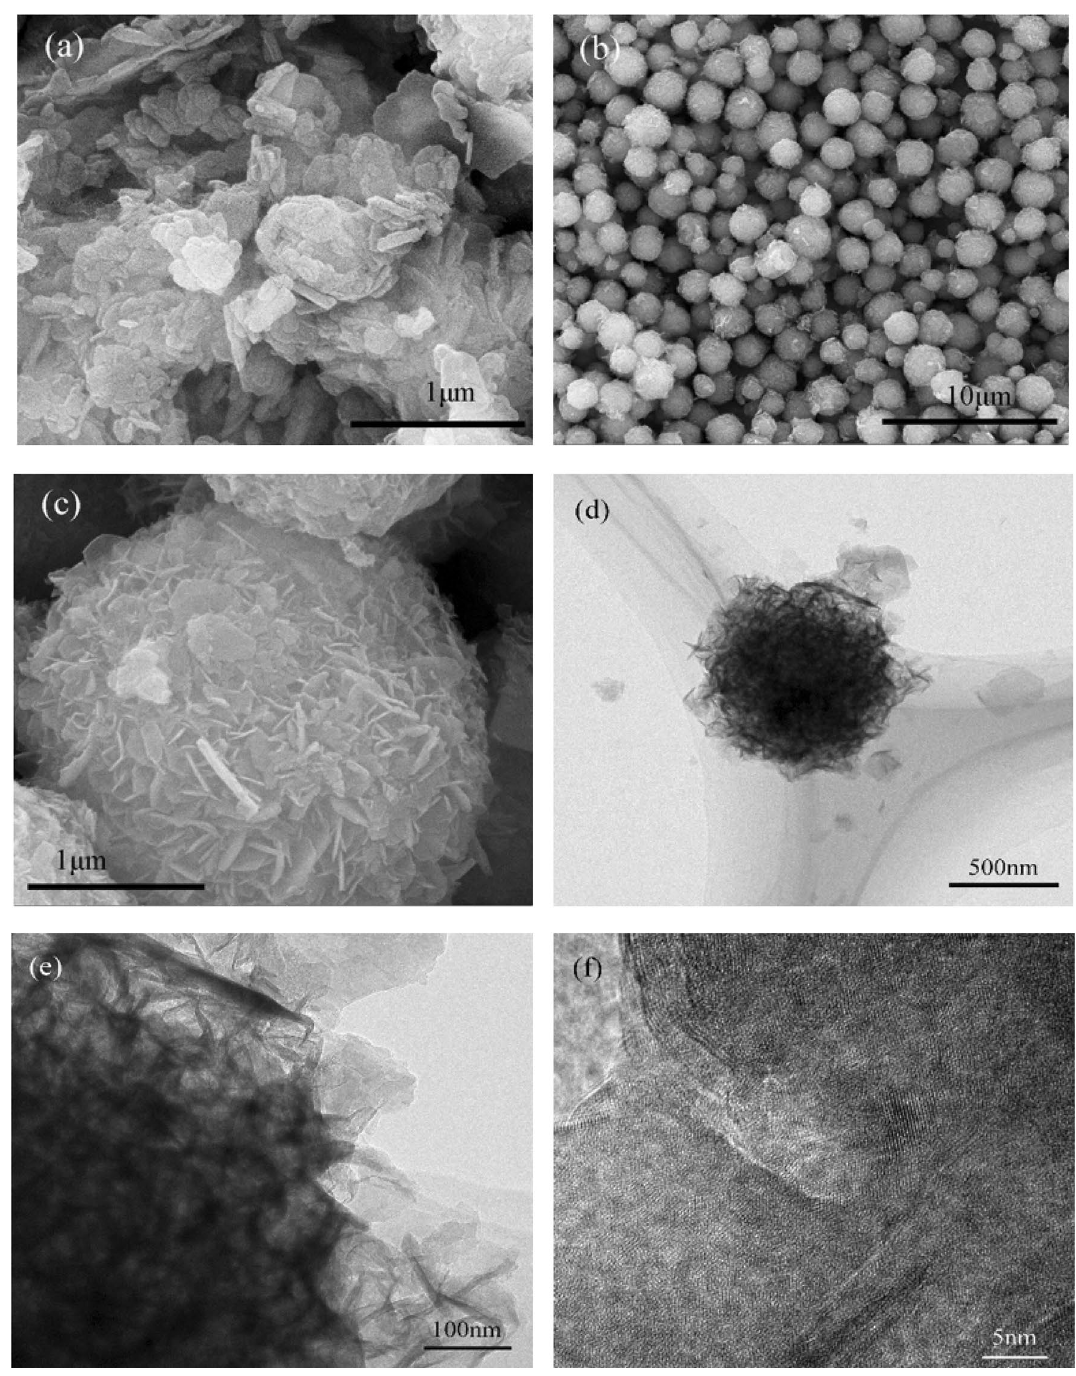
Figure 2. SEM images of ZnAl-LDHs ( a ) and ZnNiAI-LDHs ( b , c ). TEM images of ZnNiAl-LDHs ( d – f